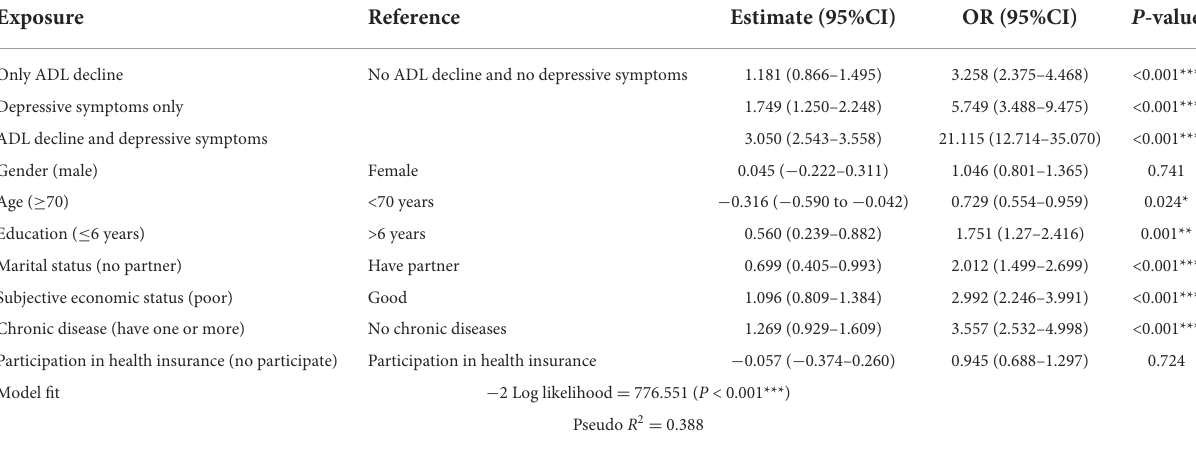
TABLE 3 Interaction effect of depressive symptoms with ADL decline on active aging with an ordinal logistic regression.